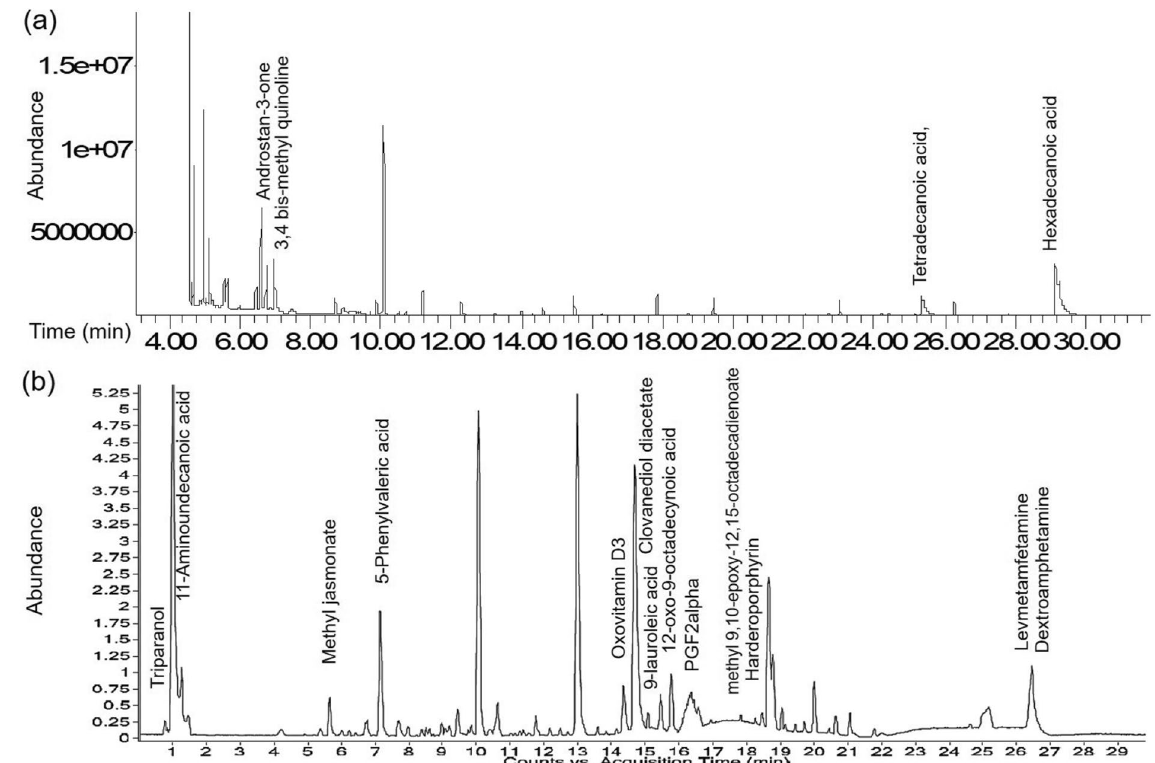
Figure 1. Chromatograms showing peaks of different phytochemicals present in CCF, ( a ) GC–MS ( b ) LC–MS analysis. Noteworthy phytochemicals are indicated in the